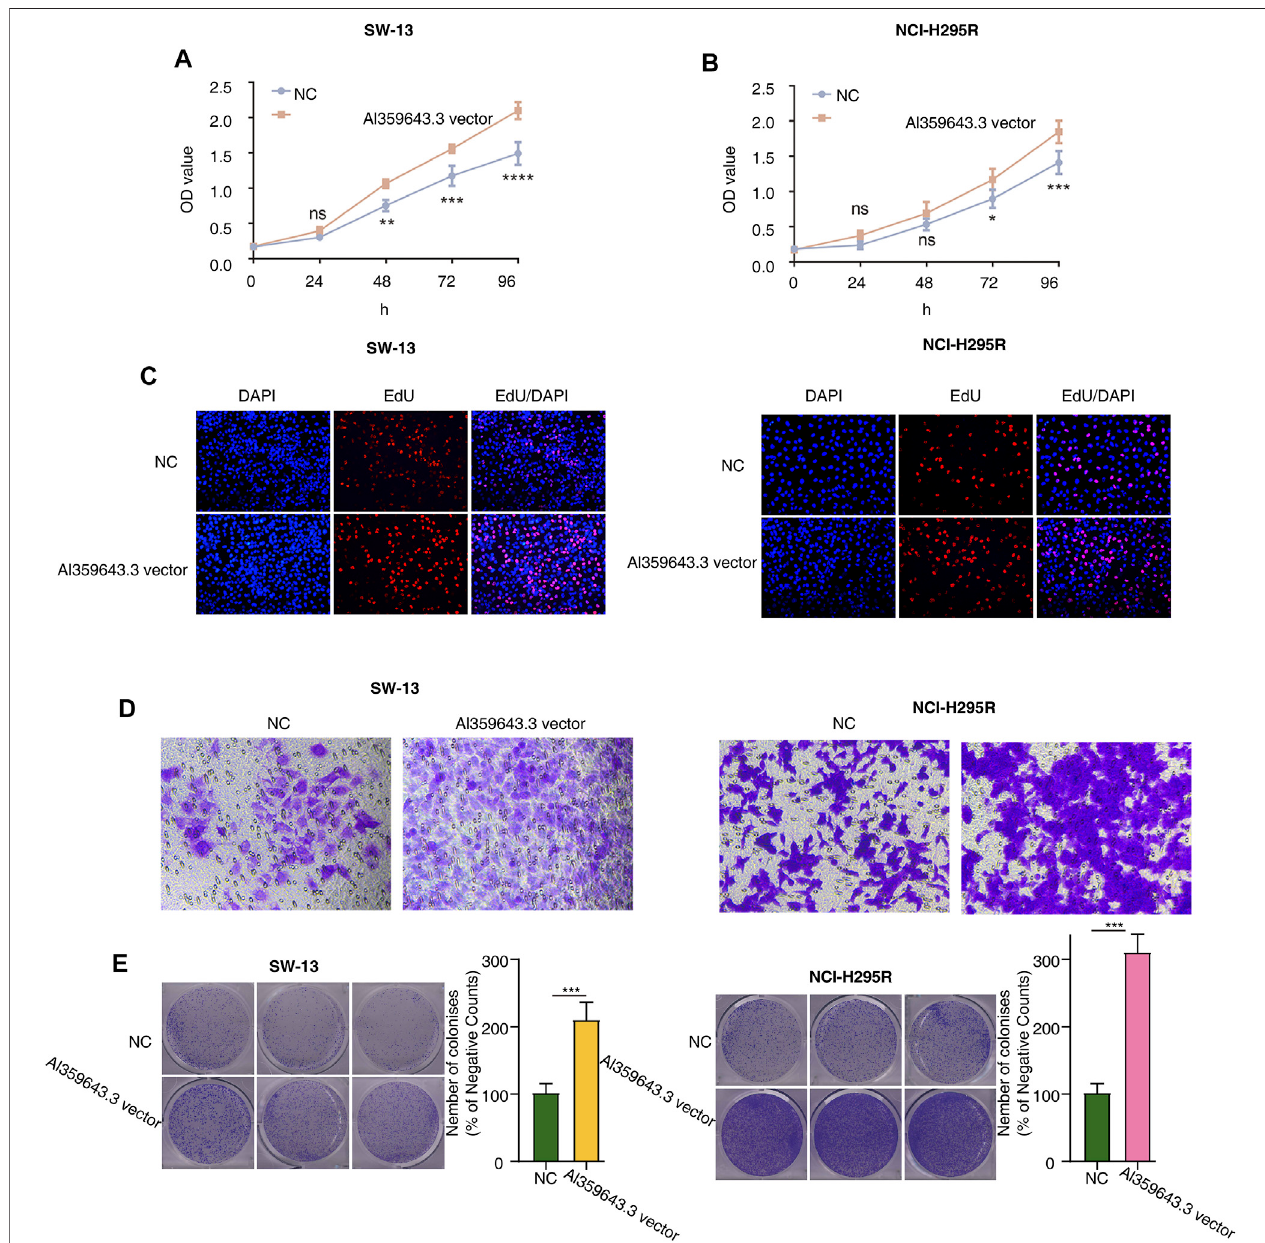
FIGURE 8 | Functional validation with AL359643.3 overexpression. (A,B) CCK8 assay was utilized to measure the impact of AL359643.3 overexpression on the proliferationofSW-13 (A) andNCI-H295 (B) cells. (C) EdU-positivecellsareintheAL359643.3vectorgrouprelativetotheirBlankvectorcounterpartsinSW-13(left)and NCI-H295 (right) cultures. (D) . Transwell assay wasperformed to measure the impact ofAL359643.3 overexpression on the invasiveness ofSW-13 (left) and NCI-H295 (right) cells. (E) . Colony formation assay was performed of different groups in SW-13 (left) cells and NCI-H295 (right) (* p < 0.05, ** p < 0.01, *** p < 0.001, **** p <